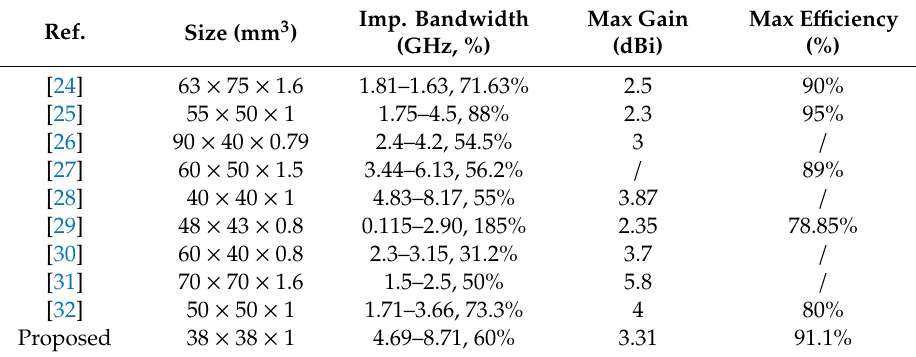
Table 1. Comparison between the proposed Antenna 1 and previously designed antennas. Ref. Size (mm 3